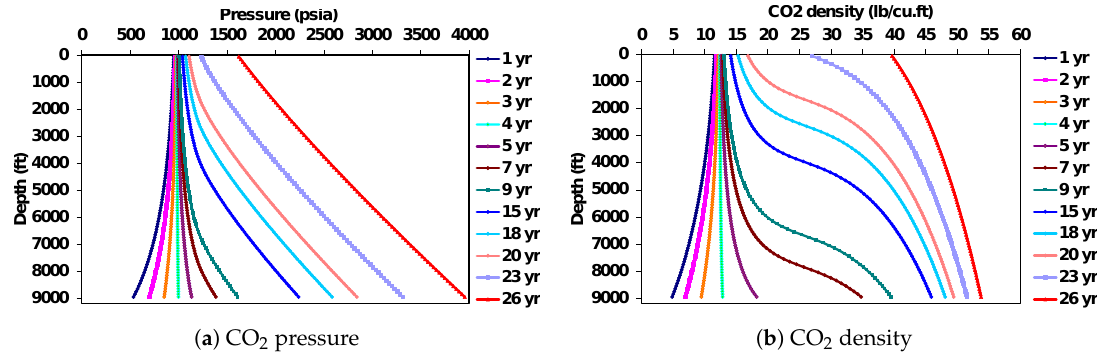
Figure 10. CO 2 behavior in the wellbore vs. depth; Case 1 with CO 2 injected in its supercritical state.